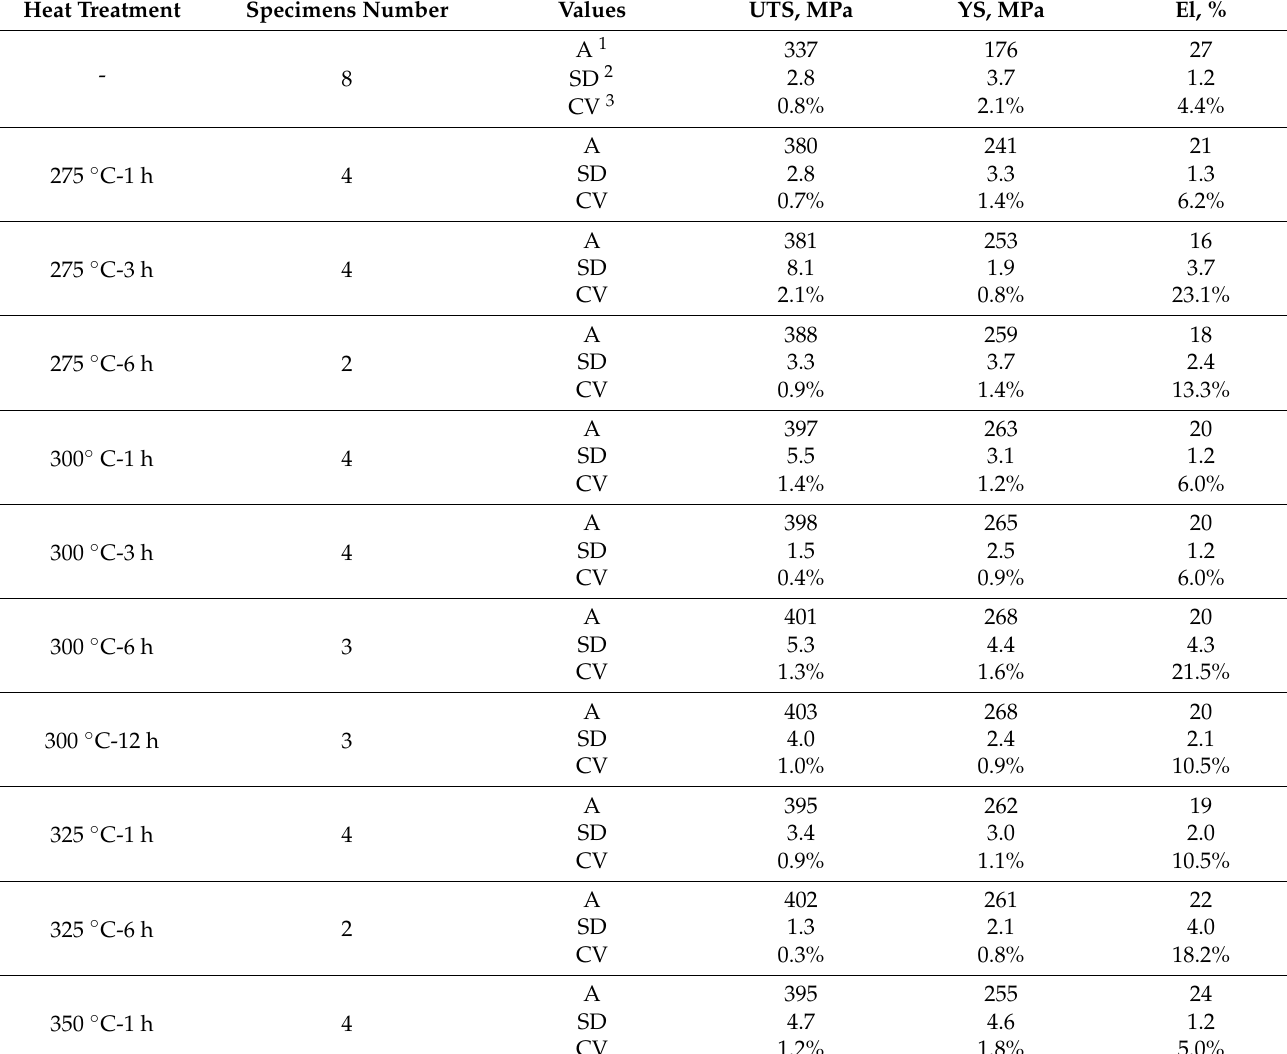
Table 5. Average values of the mechanical